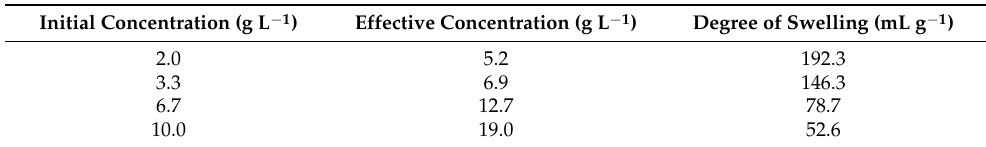
Table 5. The role of APP-E pectin concentration on the effective polymer concentration and degree of swelling of gel formed by dialysis against 1 mol L − 1 CaCl 2 .